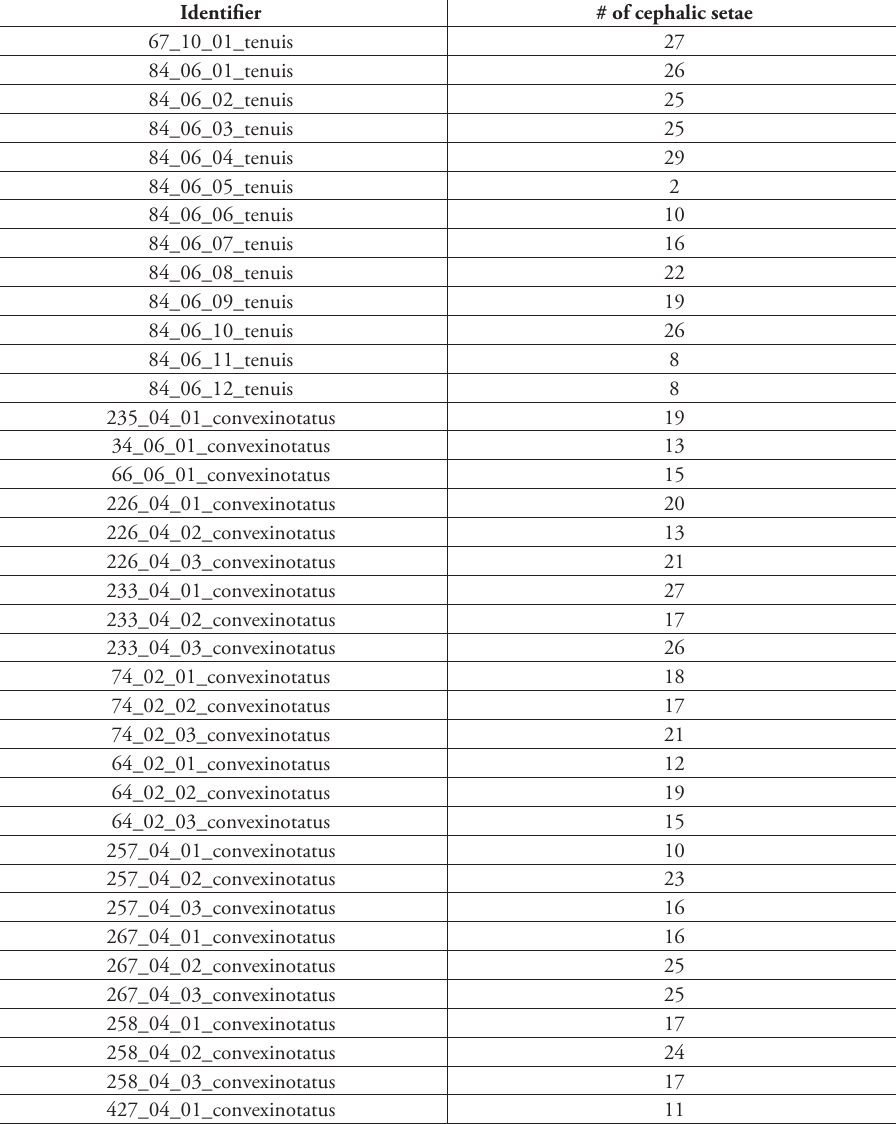
Table 4. Cephalic setae counts. Identifiers are as follows: sample #_year of